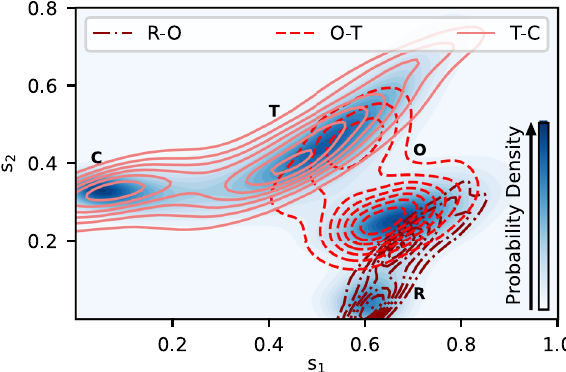
Fig. 5 Phases of BaTiO 3 in CV space. 2D contour plots of the two- component CV s = ( s 1 , s 2 ) plane across fully fl exible MD trajectories, highlighting the presence of the R-O-T-C